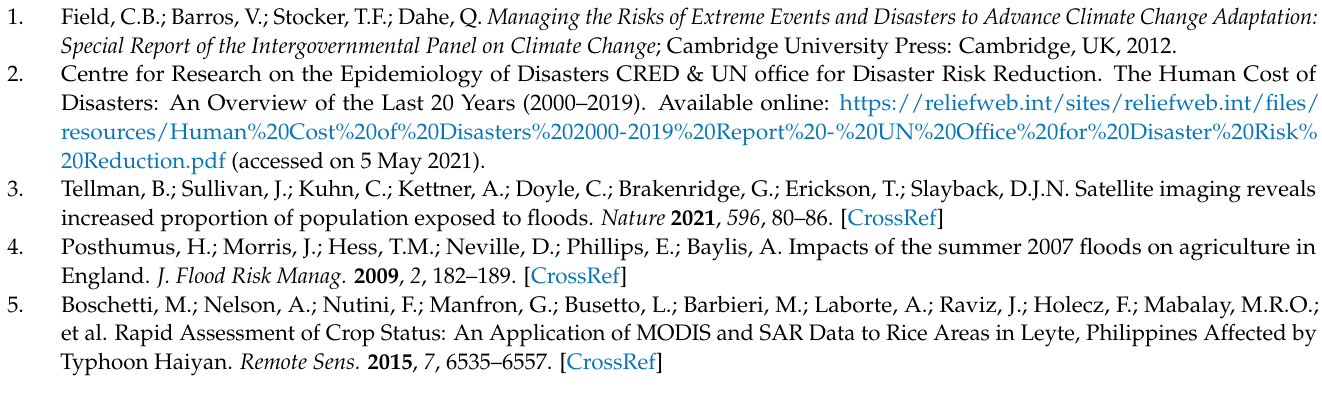
water extraction method comparison, Figure S2: Receiver operating characteristic (ROC) curve for water extraction threshold selection. The ROC curve was calculated over the dataset of 892 validation